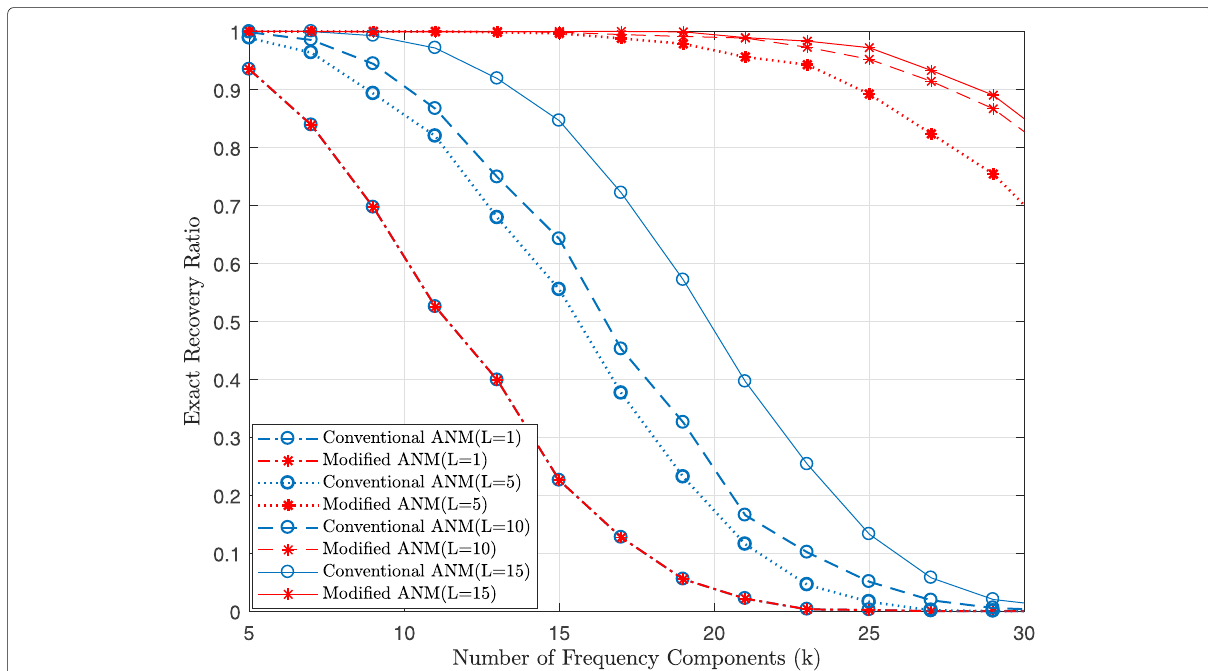
Fig. 3 The ERR performance of the conventional and modified ANM techniques when the source vectors are highly correlated